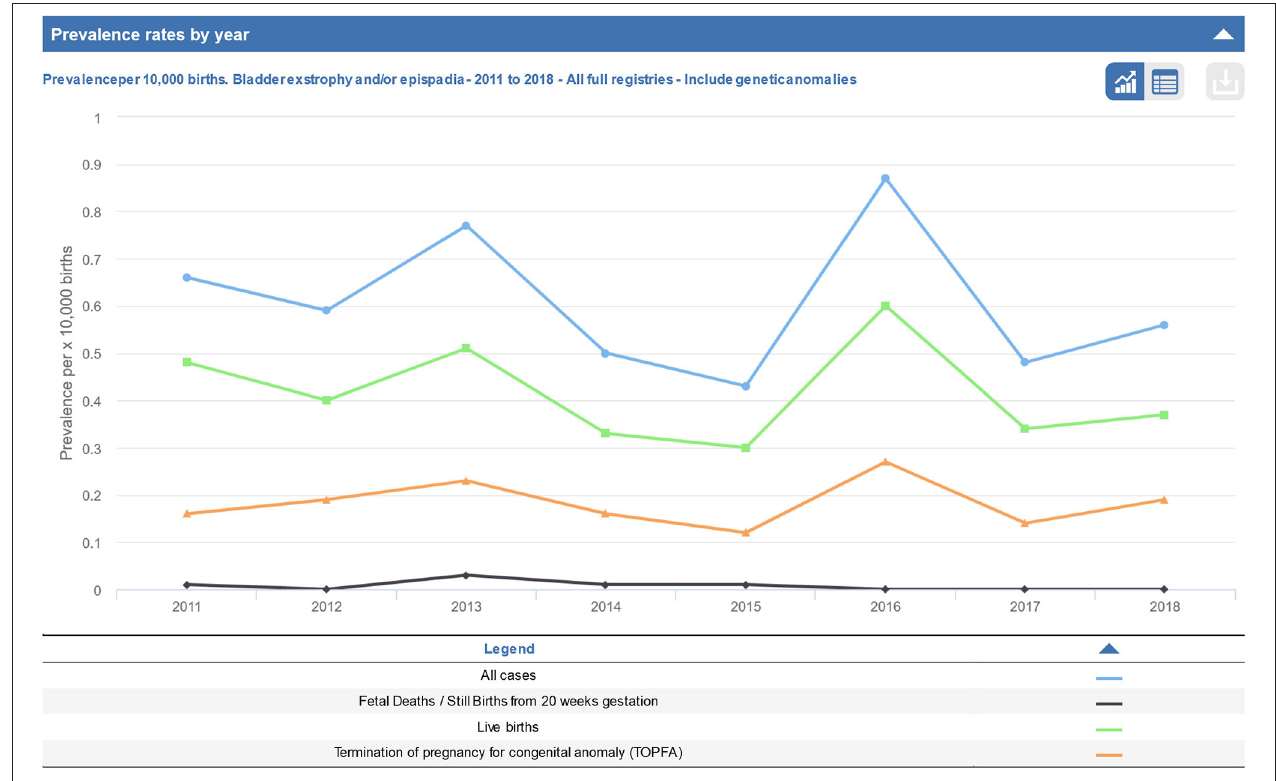
FIGURE 1 | Prevalence rate per year across all registries of bladder exstrophy and/or epispadias from 2011 to 2018 (taken from EUROCAT